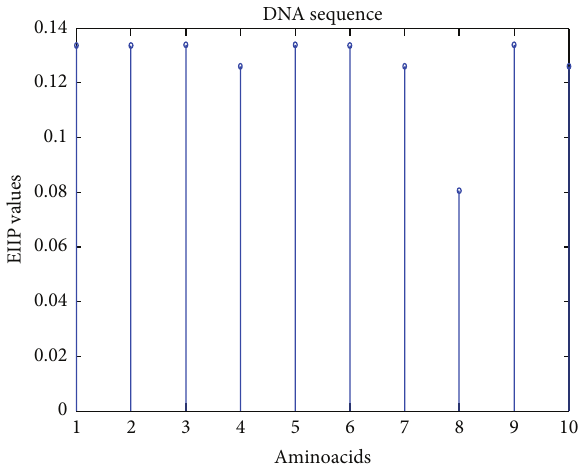
Figure 1: EIIP representation of a sample DNA